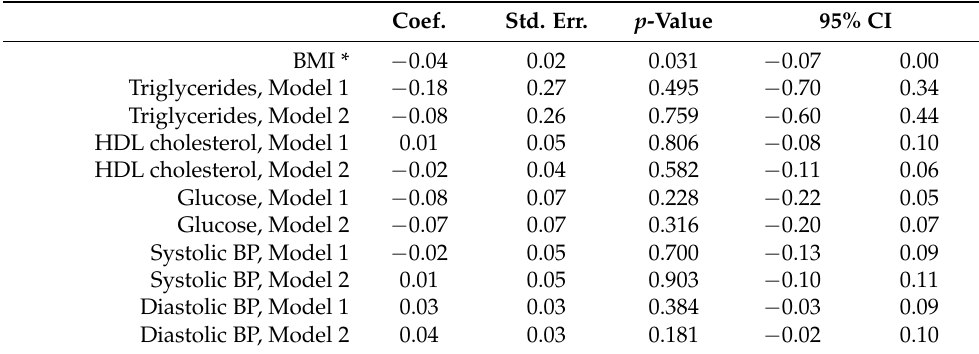
Table A1. Adjusted associations between device-measured AT (min/day) and CVD risk factors, with and without adjustment for BMI.